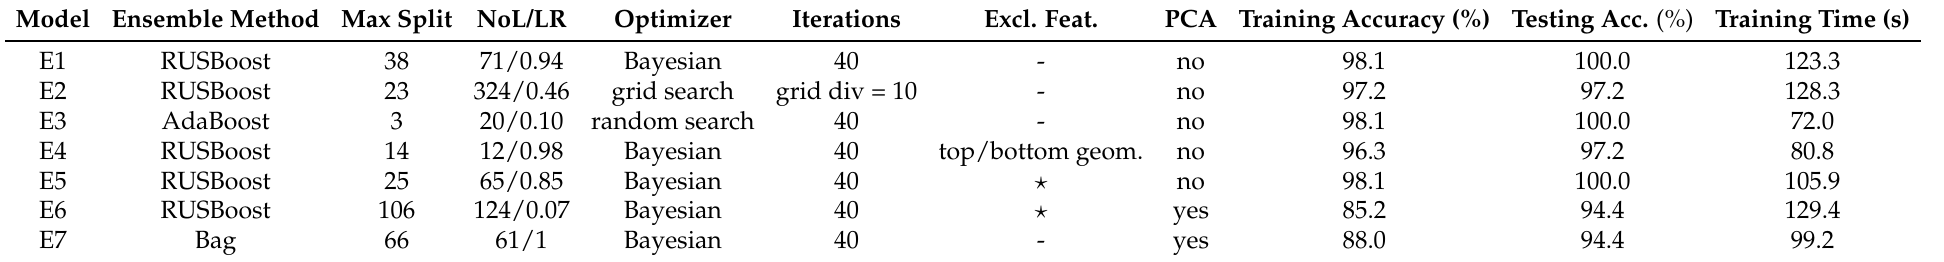
Table 6. Features of the EM models, and relevant accuracies achieved. Excl. feat. = excluded features ( (cid:63) = top/bottom geometry, diagrid total length, maximum normal force); NoL = number of learners; LR = learning rate.